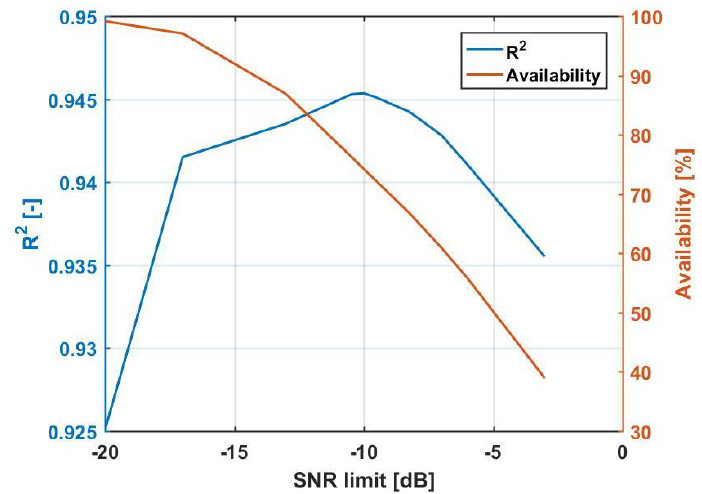
Figure 6. Coefficient of determination R 2 and availability versus the lower Signal-to-noise ratio (SNR) limit.